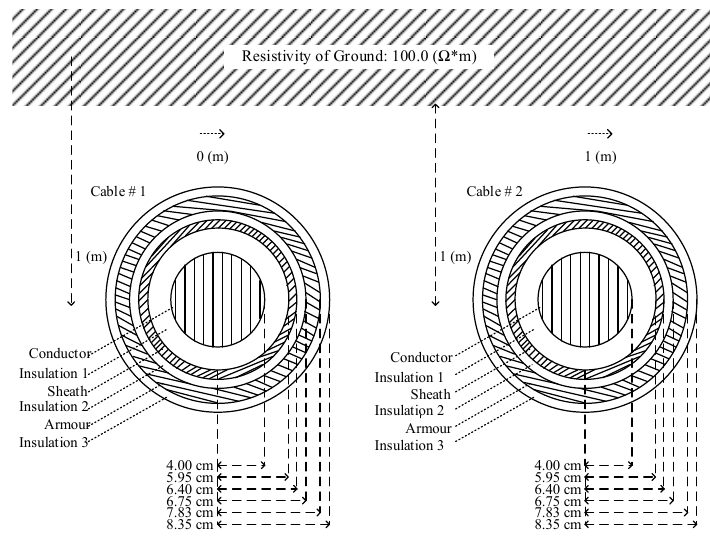
Figure 3. Cable cross-sectional layout model.